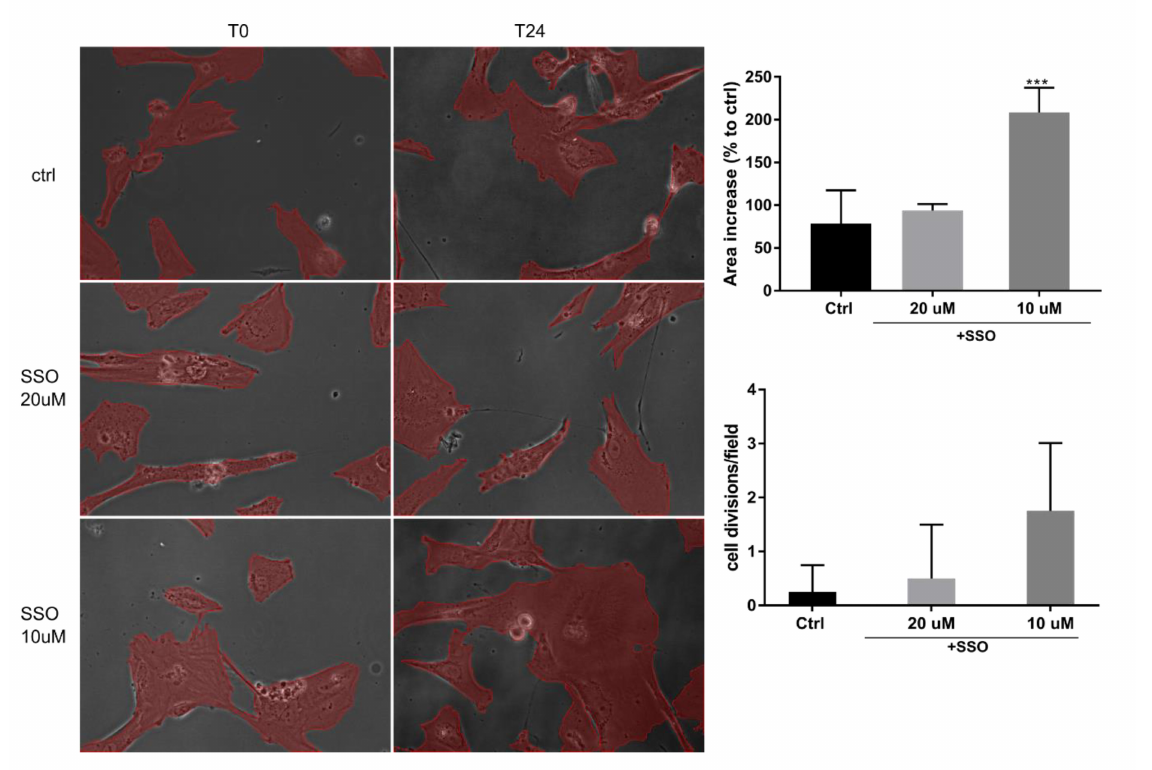
Figure 2. Short-term treatment of NHAs with SSO does not affect their viability or cell division rate. NHAs were pre-treated with SSO for 10 min at indicated concentrations, then incubated for 24 h in a time-lapse incubator. The covered area was measured post-hoc at indicated times using NisElements Br. Four fields were measured for each situation, and the statistical analysis was performed using one- way ANOVA, Dunnett multiple comparison, where data were compared to control (*** p < 0.001). Metabolites 2022 , 12 , x FOR PEER REVIEW